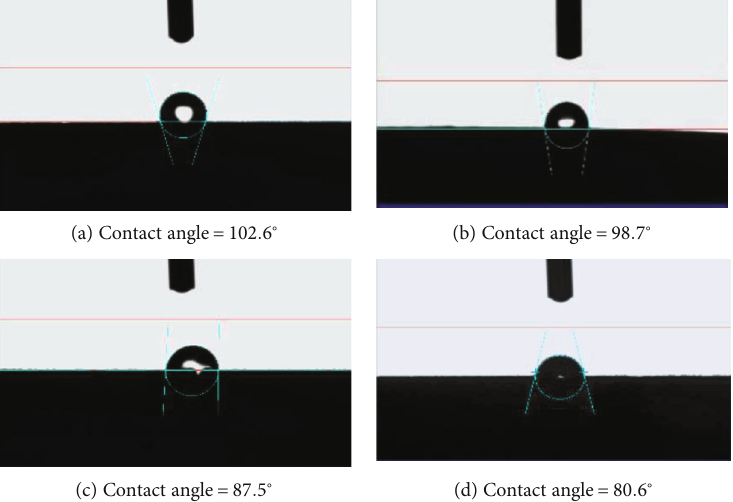
Figure 11: The measurement of contact angle test of core 17-1.